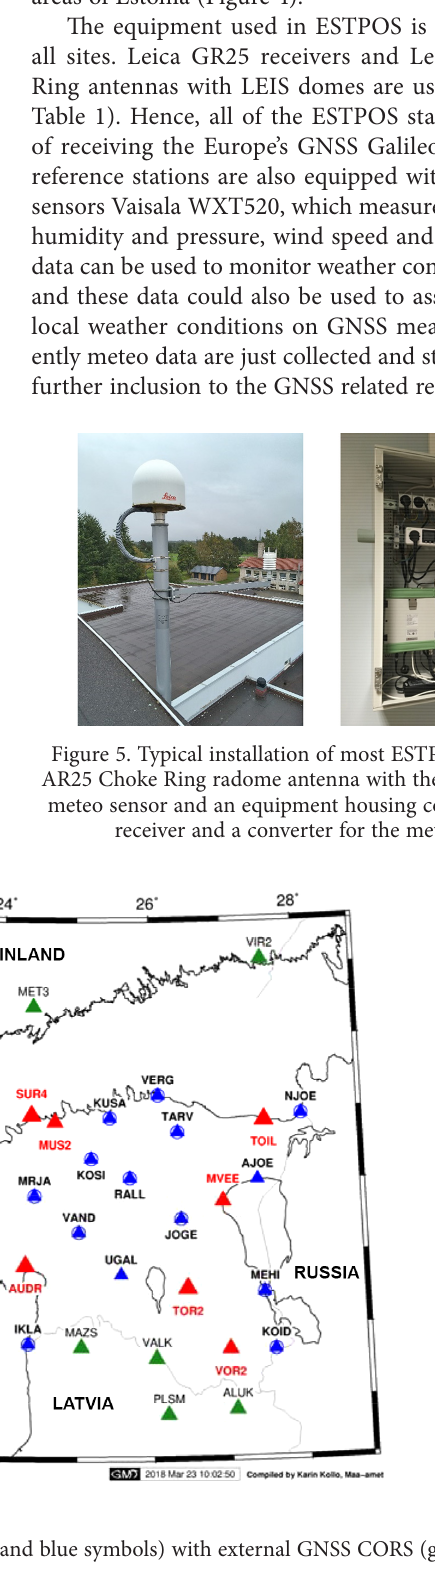
Figure 4. The modernized ESTPOS network (denoted by red and blue symbols) with external GNSS CORS (green triangles)